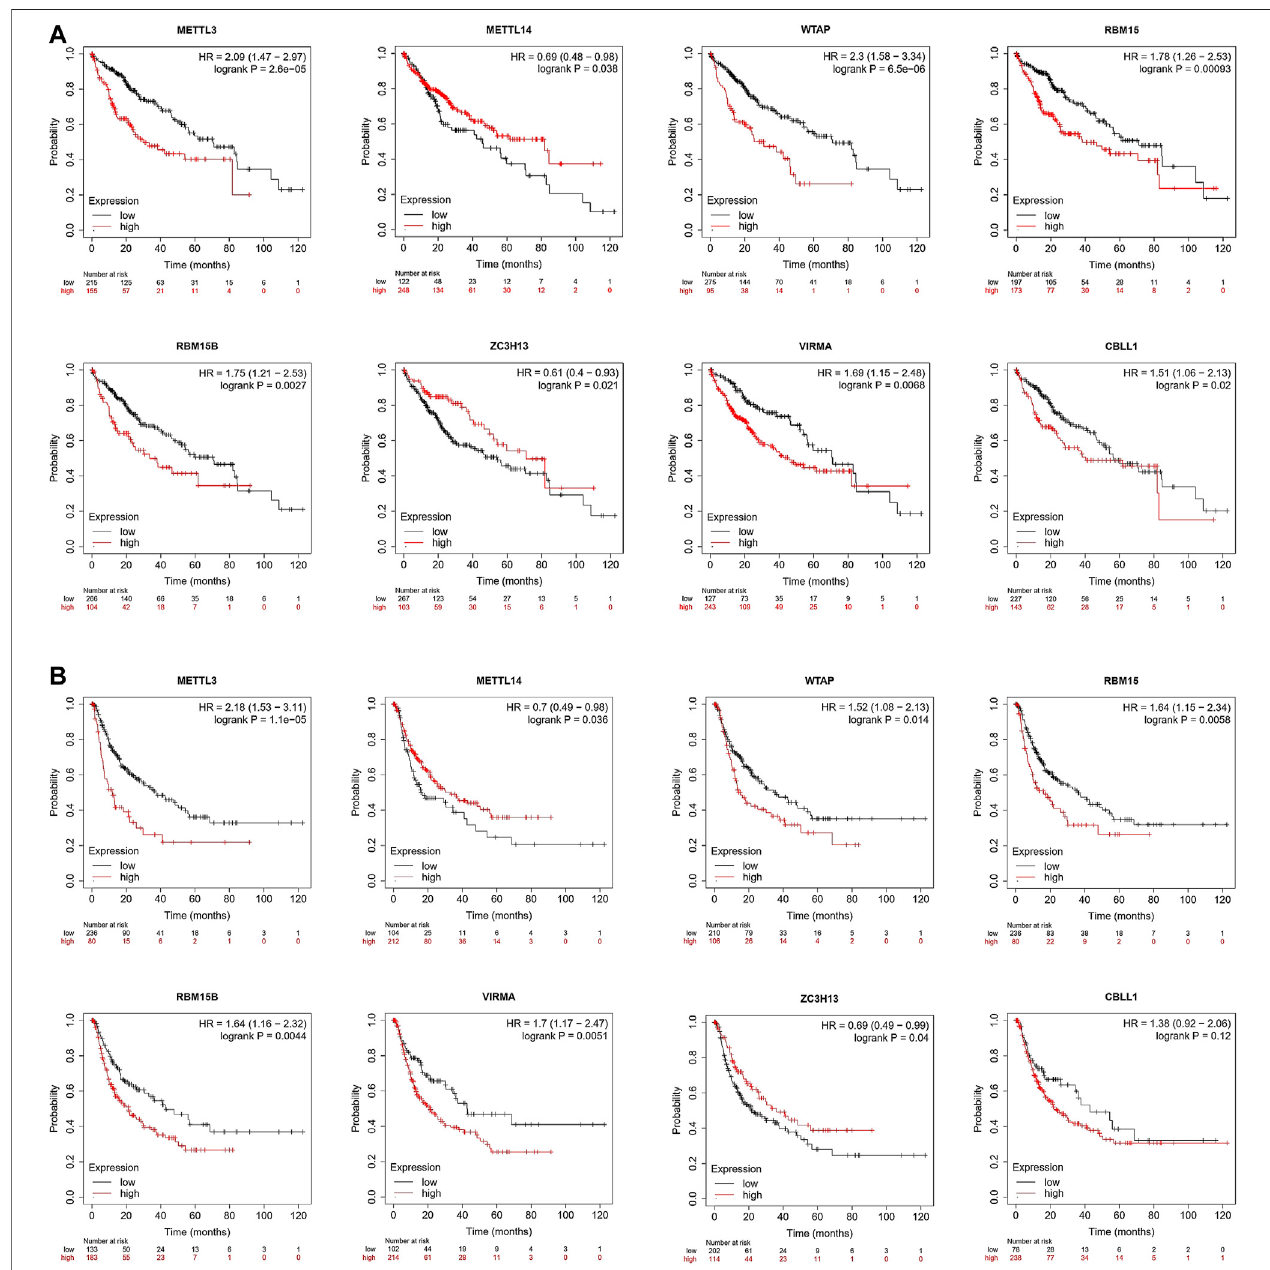
FIGURE 5 | Prognostic value of the m 6 A writer complex in HCC (Kaplan – Meier Plotter). The correlation between expression of the m 6 A writer complex genes and overallsurvival(OS) (A) andrelapse-freesurvival(RFS) (B) inHCC.Dataareshownasthehazardratiowitha95%con fi denceinterval.Log-rank p < 0.05wasregardedas statistically signi fi